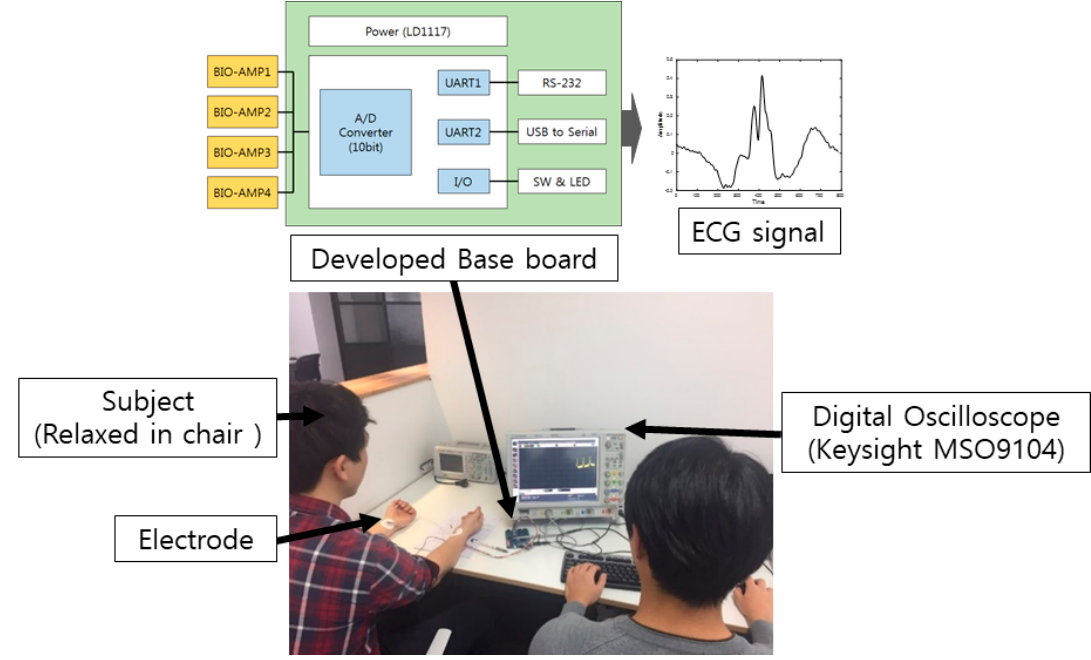
Figure 9. Environment for acquiring the Chosun University (CU)-ECG signals.